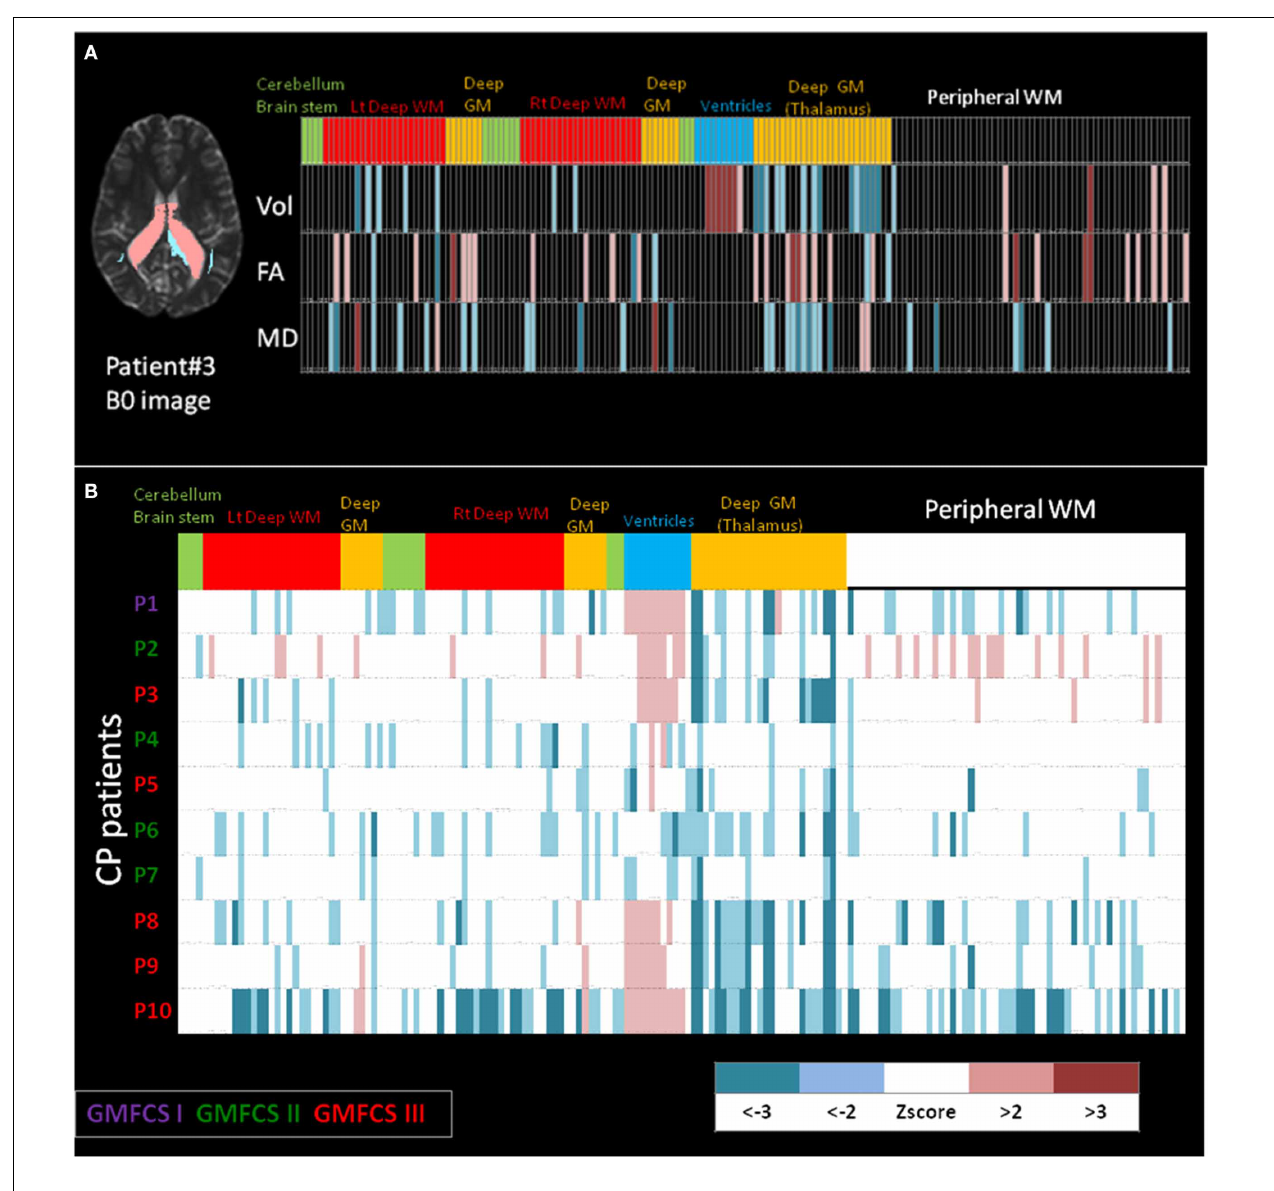
FIGURE 6 | (A) Feature vector from the personalization DiffeoMap correspondence between the atlas and an individual’s coordinate system associated with focal disease category. Informatics partition with 200 structures including, volume, FA and MD values into peripheral white and gray matter, and deep white and gray matter structures. The features are color coded according to the statistics to depict color-coded outliers: WM: